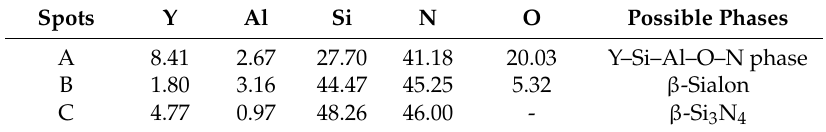
Table 2. EDS (energy dispersive spectroscope) chemical analysis (at %) of different positions in Figure 2. Spots Y Al Si N O Possible Phases A 8.41